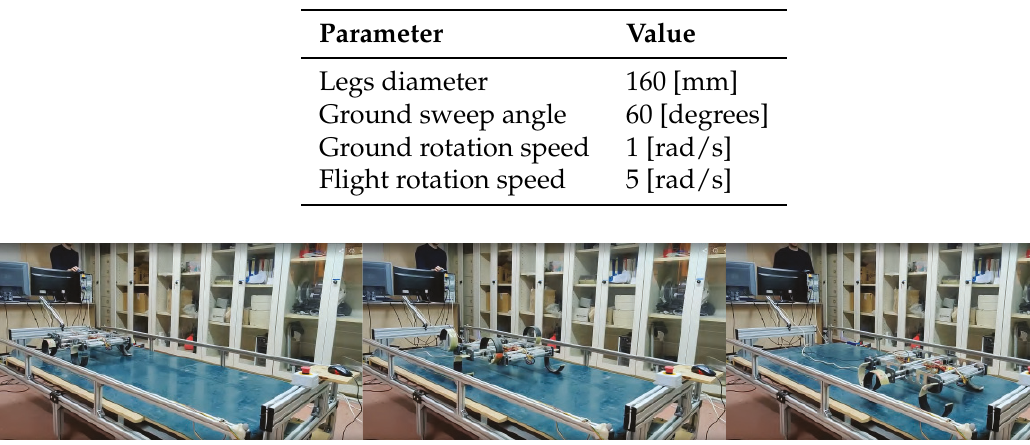
Figure 15. CLHeRo forward tests—scenario 1.